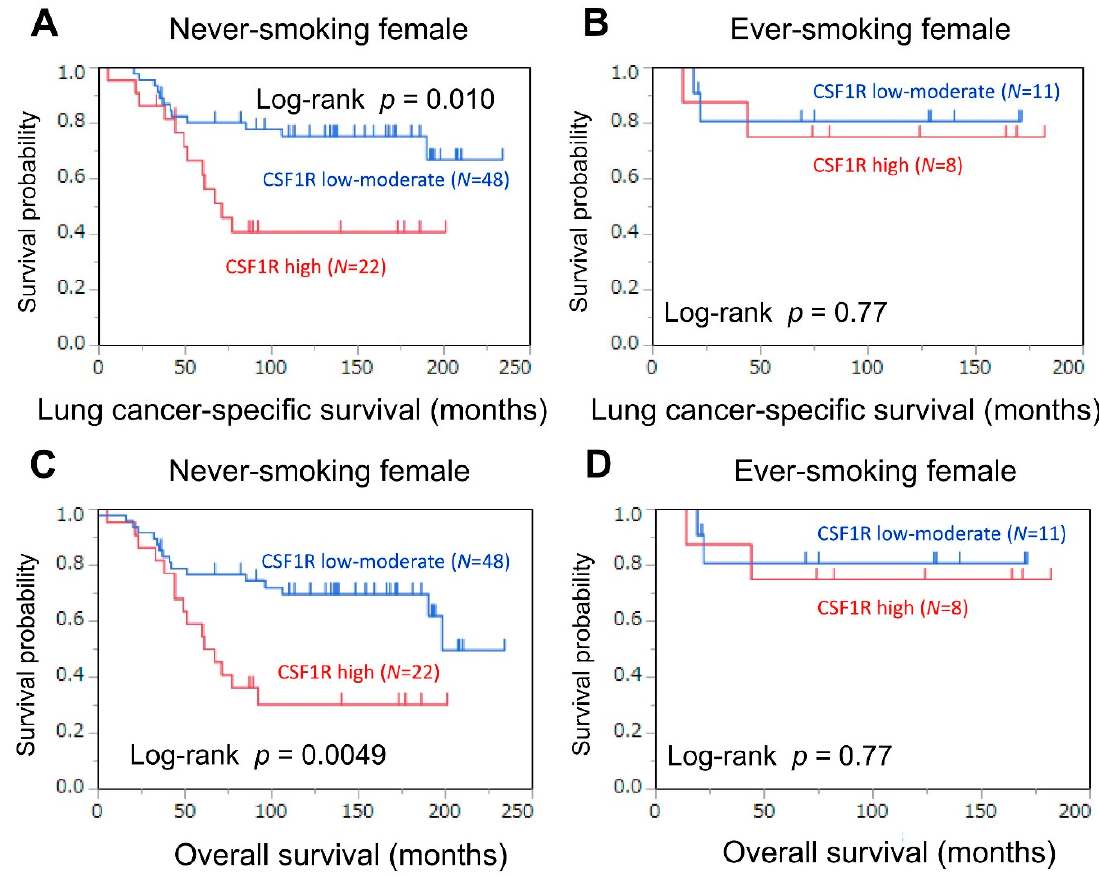
Figure 4. Kaplan–Meier curves for lung cancer-specific ( A ) and overall ( C ) survival, according to CSF1R expression status in tumor-associated macrophages (low–moderate vs. high), in never-smoking female patients. Kaplan–Meier curves for lung cancer-specific ( B ) and overall ( D ) survival, according to CSF1R expression status in tumor-associated macrophages (low–moderate vs. high), in ever-smoking female patients.